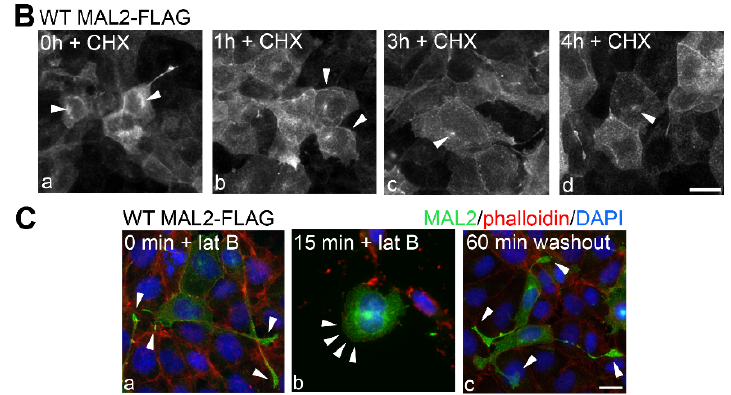
Figure 5. MAL2 expression in Clone 9 cells is associated with actin-based protrusion formation. ( A ) Uninfected Clone 9 cells and Clone 9 cells expressing wild type (WT) MAL2 were immunolabled for MAL2 (with anti-FLAG antibodies) and actin (with phalloidin). Nuclei were also stained with DAPI and merged images are shown in panels c and f. Arrowheads are marking actin-based protrusions in MAL2-expressing cells. ( B ) Clone 9 cells expressing FLAG-tagged wild type MAL2 were treated 50 µg/mL of cycloheximide (CHX) for up to 4 h as indicated and immunolabeled for MAL2 with anti-FLAG antibodies. Arrowheads indicate MAL2 localization at the Golgi (a), at the cell surface (b) and in the apical compartment (c,d). ( C ) Clone 9 cells expressing FLAG-tagged wild type MAL2 were immunolabeled for MAL2 (with anti-FLAG antibodies), actin (with phalloidin) and nuclei (with DAPI) after treatment with 5 µM latrunculin B (lat B) for 0 or 15 min or after washout for 60 min. Arrowheads in panels a and c mark long, actin-based protrusions in untreated cells and cells after latrunculin B washout. In panel b, arrowheads point to the smooth cell surfaces with no actin-based protrusion in cells treated for 15 min with latrunculin B. Bar = 10 µm.